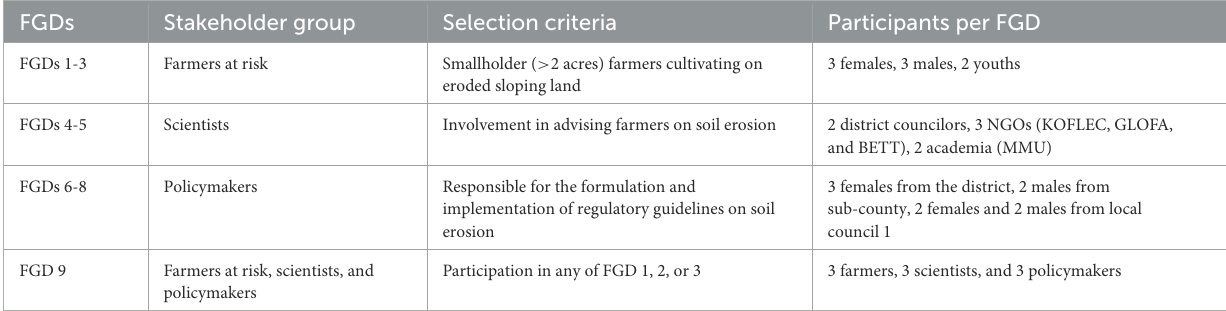
TABLE 2 Details of FGDs